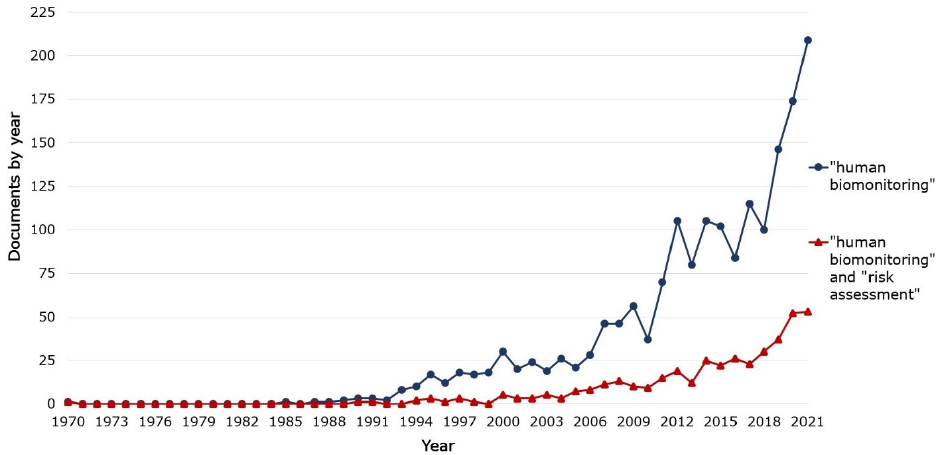
Figure 1. Documents by year for two types of searches using keywords on Scopus: “human biomonitoring” and “human biomonitoring” and “risk assessment” [20,21].